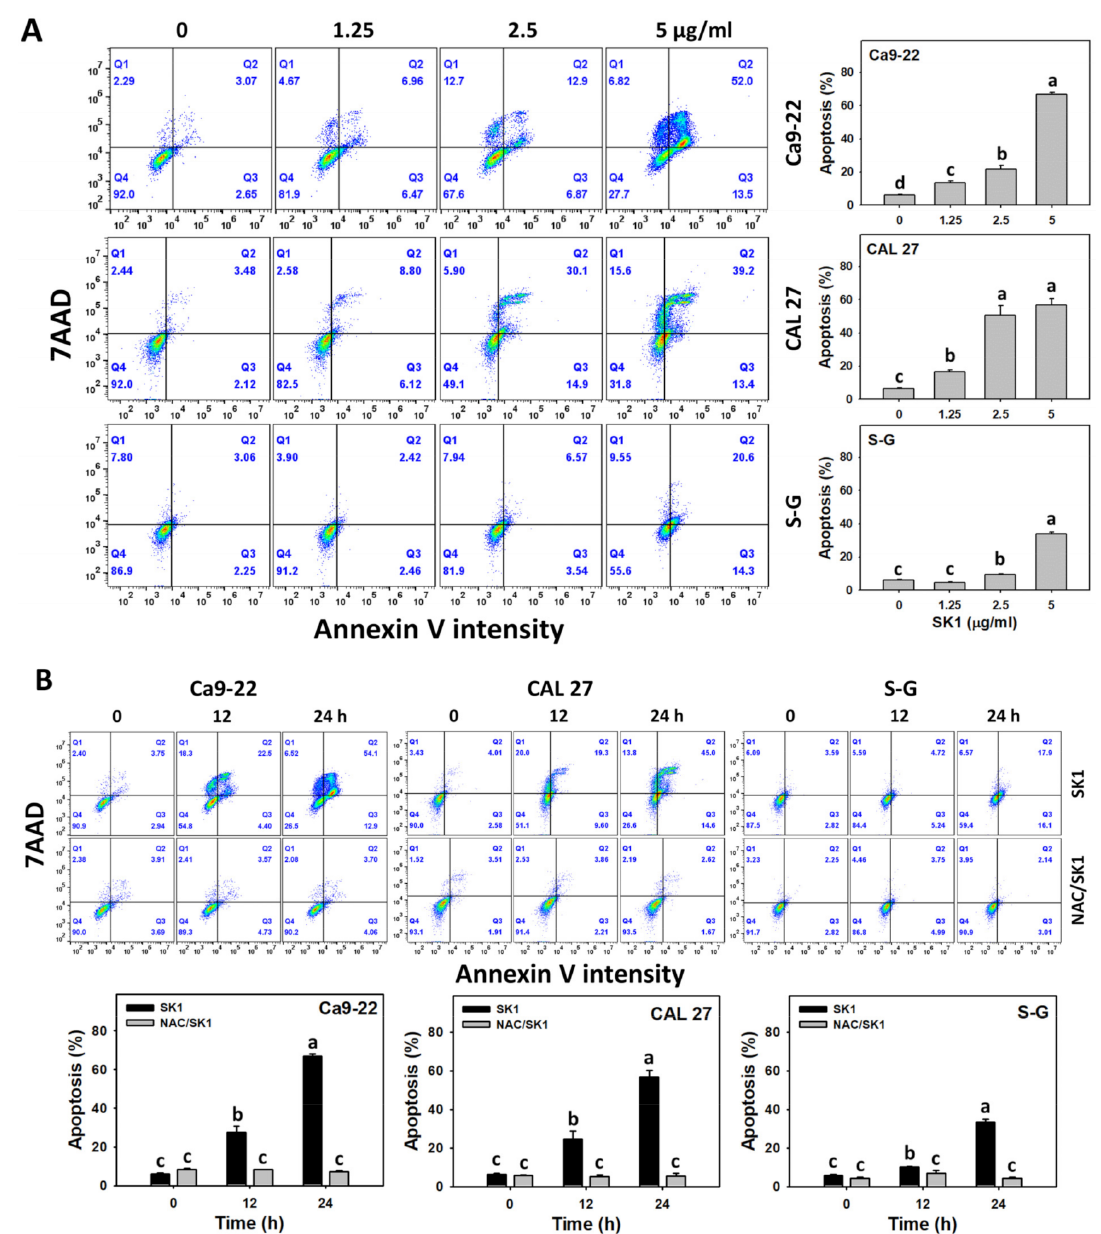
Figure 3. Apoptosis effects (annexin V) of SK1. ( A ) Annexin V/7AAD assays of SK1. Non-malignant (S–G) and oral cancer (Ca9-22 and CAL 27) cells were treated with SK1 (0 (0.1% DMSO in medium), 1.25, 2.5, and 5 µ g/mL) for 24 h. ( B ) Annexin V/7AAD assays of NAC/SK1. NAC/SK1 indicated that cells were pretreated with NAC and posttreated with SK1 5 µ g/mL for 0, 12, and 24 h. Apoptosis (%) is counted for percentage of annexin V (+)/7AAD (+/ − )(%). Data, mean ± SD ( n = 3). Statistical software provided non-overlapping low-case letters indicate significant results for multi-comparison ( p <